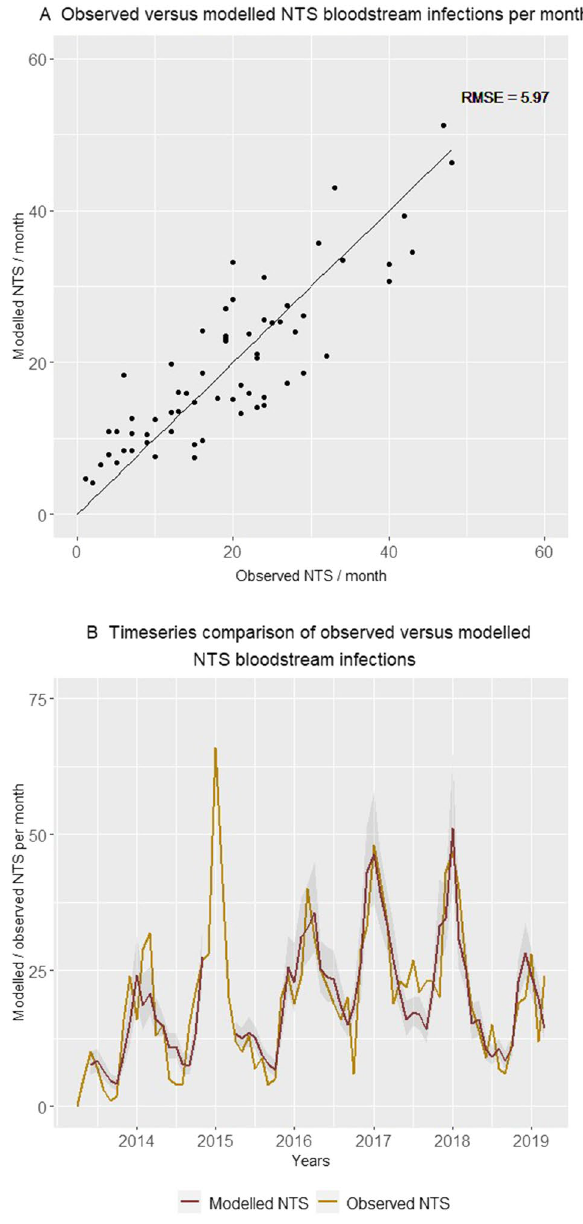
Figure 5. Comparison of the number of non-typhoidal Salmonella (NTS) bloodstream infections in children under five years old admitted to Kisantu general referral hospital that were observed and modelled by the final model per month. In panel A, pairs of observed and modelled NTS infections are displayed. In Panel B, the observed (gold) and the modelled (red) number of NTS infections with the 95% confidence interval of modelled NTS infections (grey) are displayed as a timeseries. The gap (December 2014–May 2015) in the modelled number of non-typhoidal Salmonella bloodstream infections is caused by missing data for the number of children with severe acute malnutrition admitted to the nutritional unit from December 2014 till February 2015. Abbreviations: NTS, non-typhoidal Salmonella ; RMSE, Root Mean Square